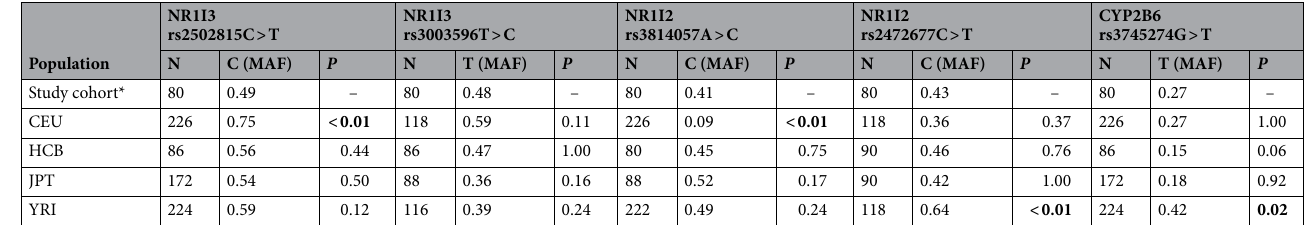
Table 2. Comparison of minor allele frequencies between the study cohort and the HapMap reference populations [ * Ethiopians; CEU—Utah residents of Northern and Western European ancestry; HCB—Han Chinese from Beijing, China; JPT—Japanese from Tokyo, Japan; MAF—Minor allele frequency in the study cohort; N—Sample size; YRI—Yoruba trios from Ibadan, Nigeria]. Significant values are in